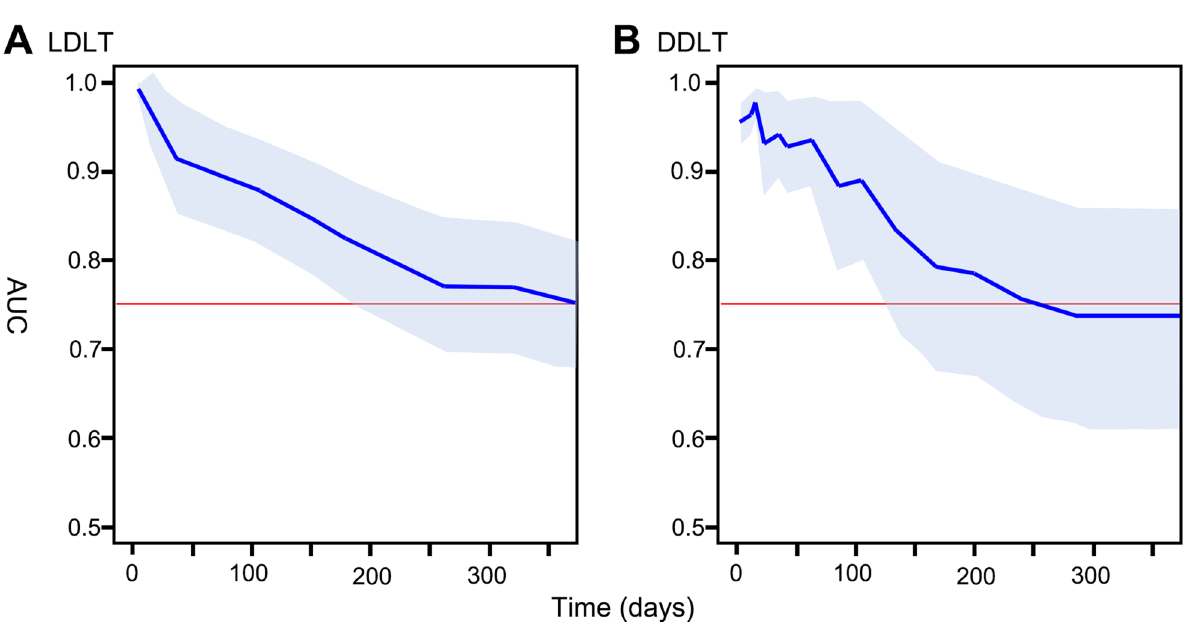
Figure 4. Time-dependent AUC curves during the 1-year post-transplantation period ( A ) in LDLT cases ( B ) and DDLT